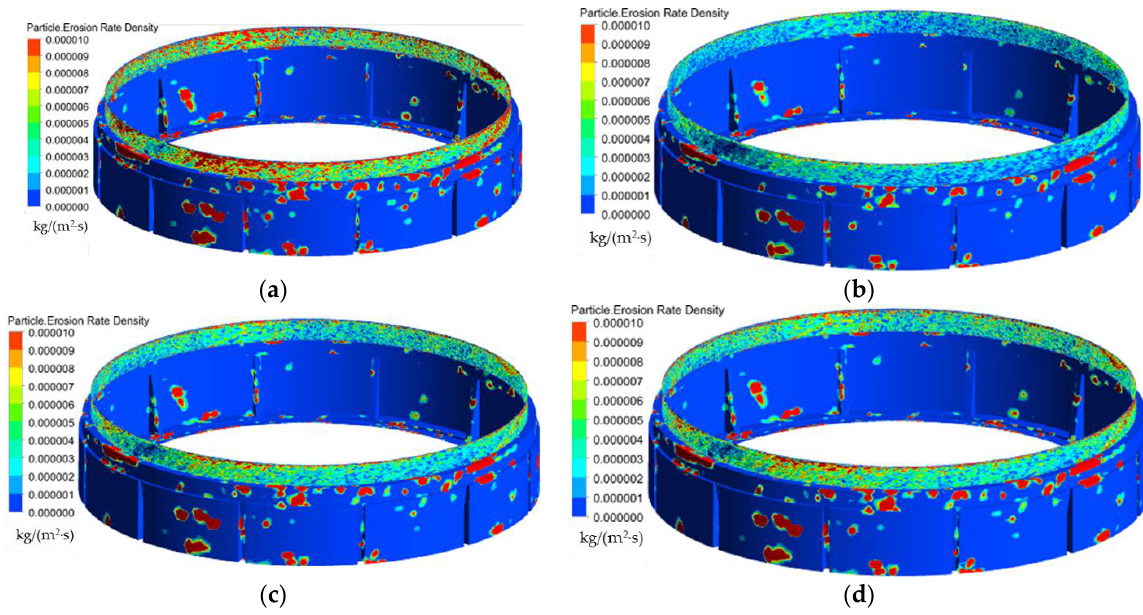
Figure 12. Erosion distribution of band under different guide vane opening. ( a ) 10 ◦ , ( b ) 20 ◦ , ( c ) 25 ◦